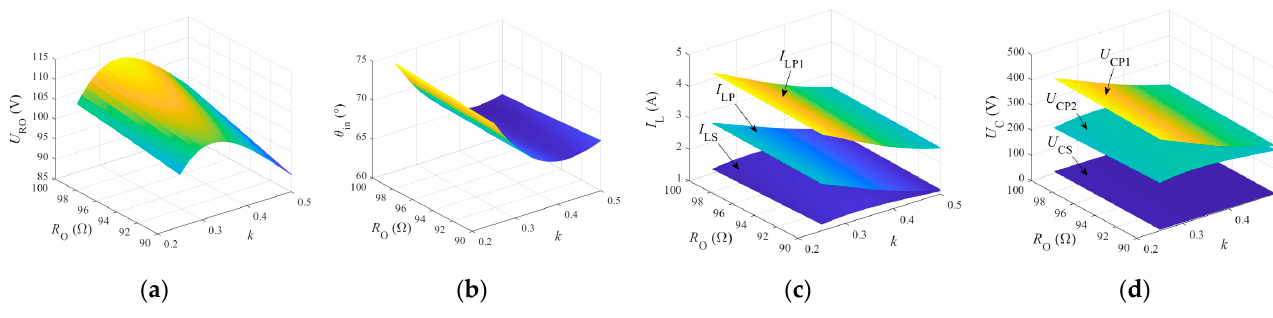
Figure 9. Main electrical values of CCO-type IPT system in case B: ( a ) output voltage; ( b ) input impedance angle; ( c ) current stresses on inductor and coils; ( d ) voltage stresses over capacitors.